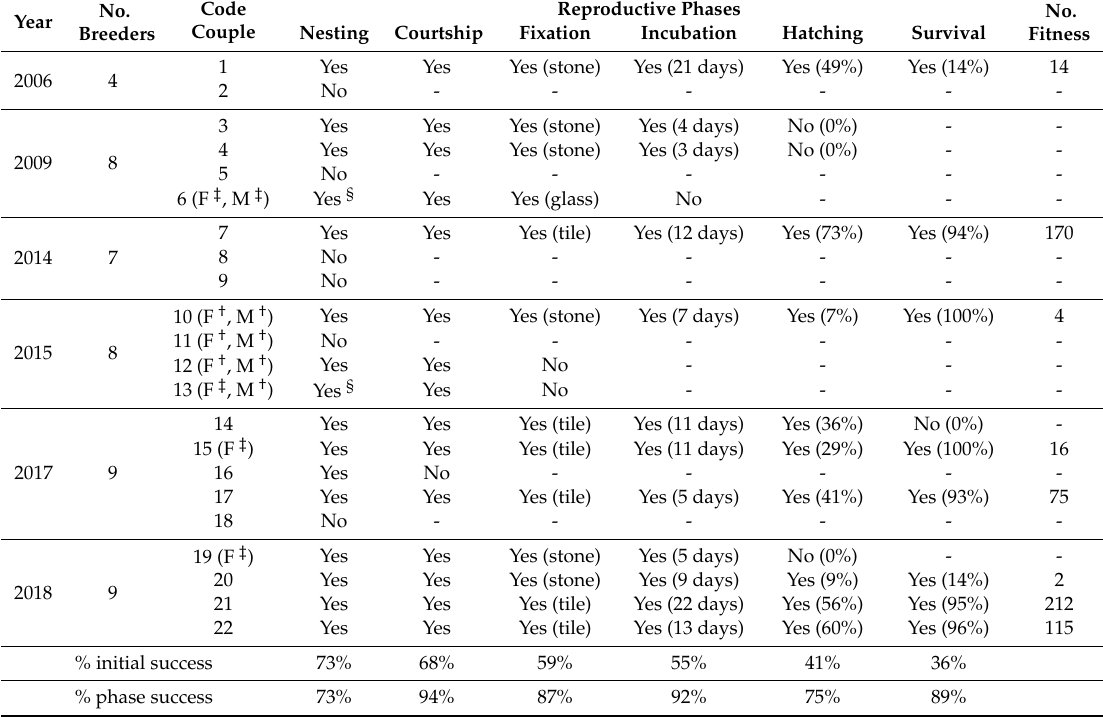
Table 2. Final results summary per year with total number of breeders present in the season and numerical code of each formed couple. Couples 14–15, 16–17 and 19–20 are formed with the same three males and di ff erent females. Where F = female, M = male. Apart from the success (Yes or No) it is indicated in parentheses the fixation substrate, the number of days during which the male takes care of the eggs, the hatching rate and the survival rate. † Individuals maintained at least one year in captivity. ‡ Individuals born in captivity. § Only female nesting behaviour is considered as